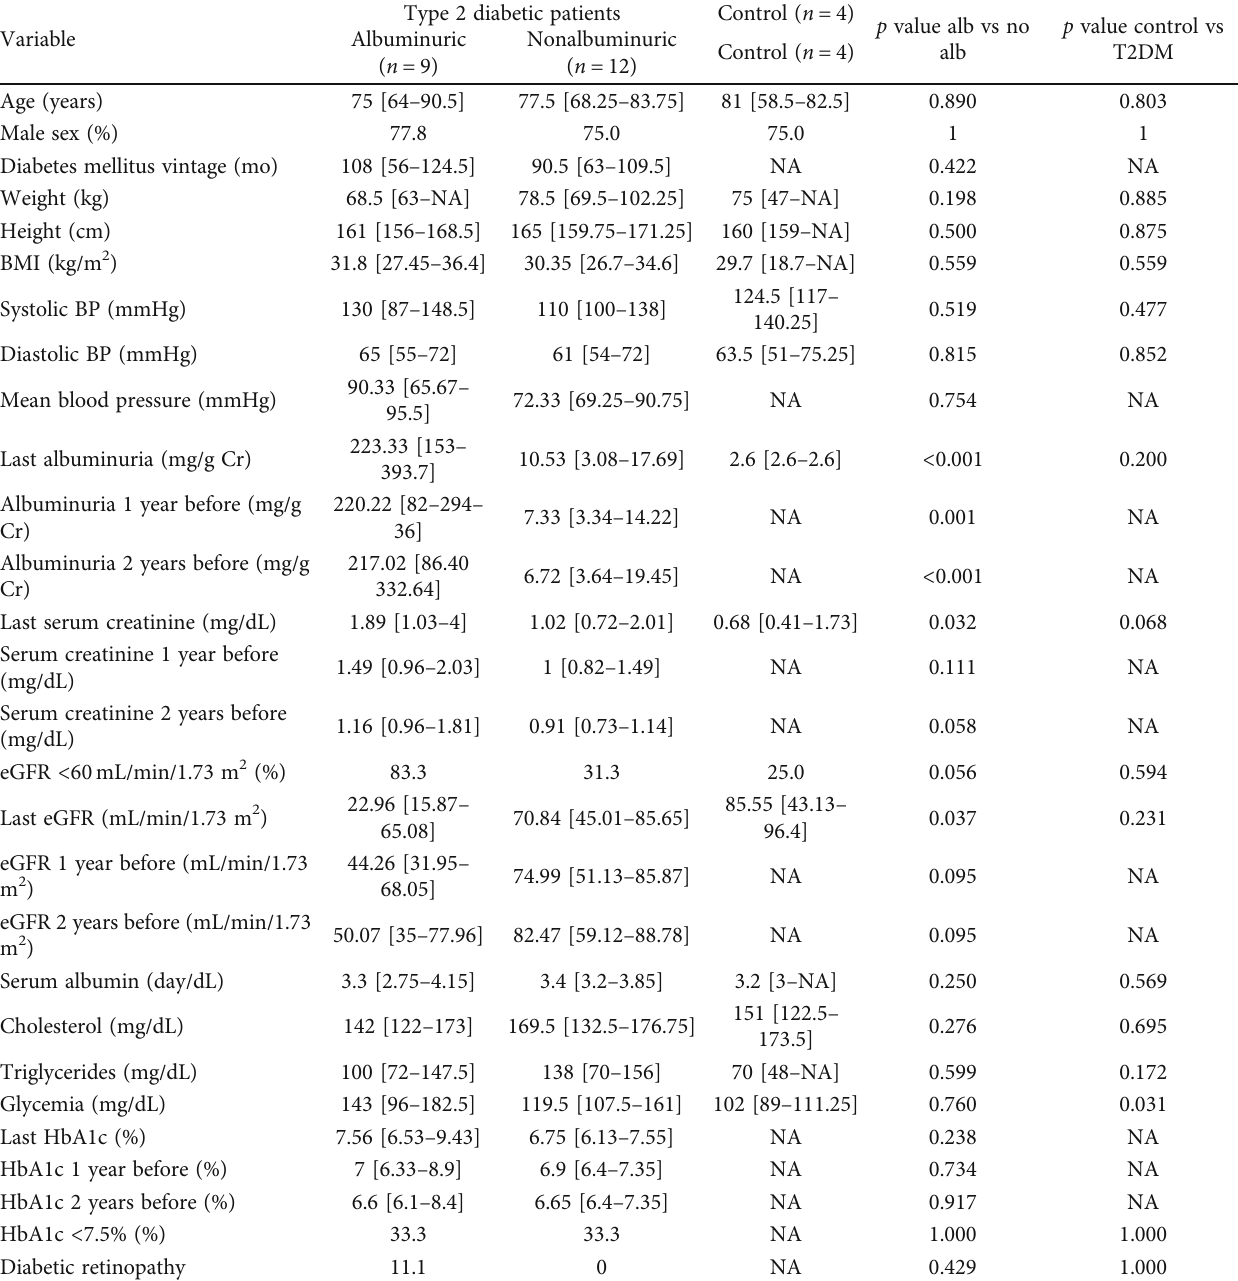
Table 1: General patient characteristics: most recent clinical and analytical data (median and interquartile range, percentage).